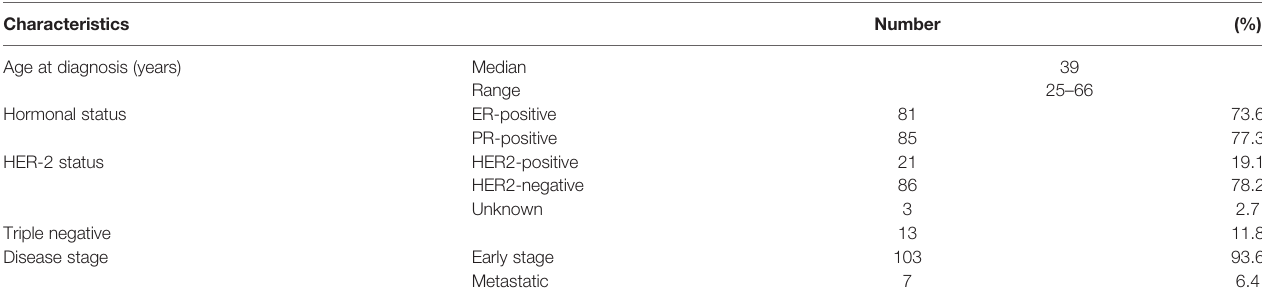
ER, estrogen receptor; PR, progesterone receptor; HER2, human epidermal growth factor receptor